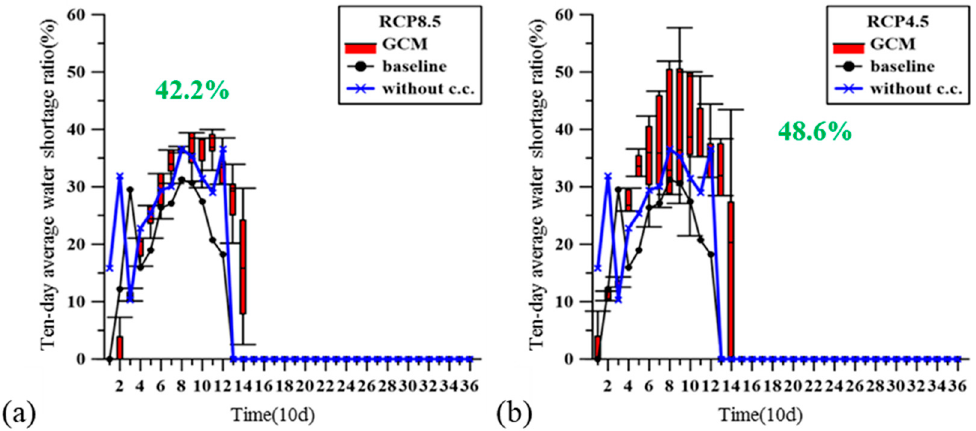
Figure 9. Water shortage ratio (R) of Formosa Plastics Corporation (FPC) under RCP 8.5 ( a ) and 4.5 ( b ) (The abbreviation without c.c. means the baseline weather data and future water demand are used in simulation).